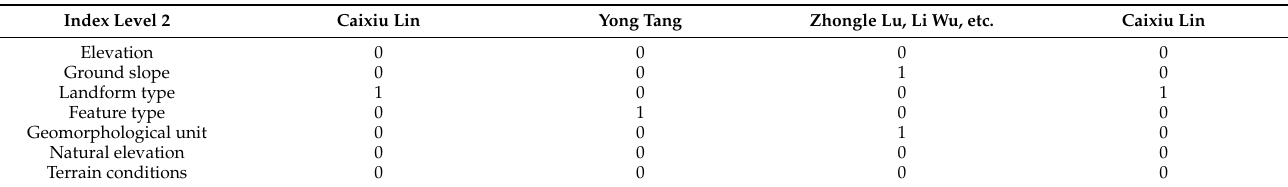
Table A8. Second level index binarization matrix.